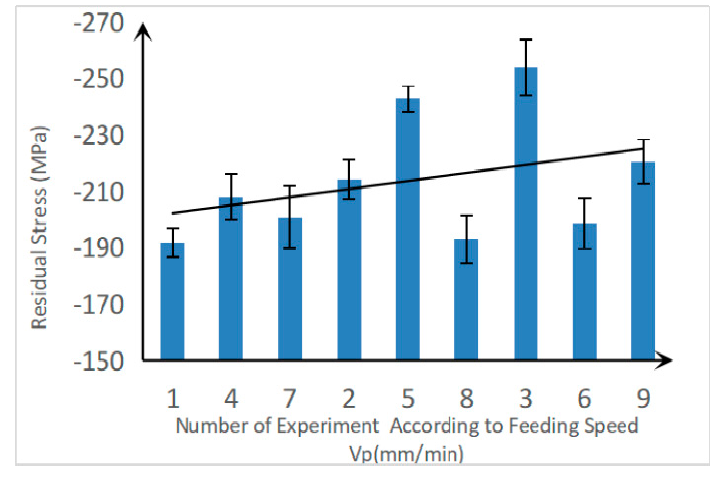
Figure 15. Relationship between the surface residual stress and the feed rate of the grinding head.